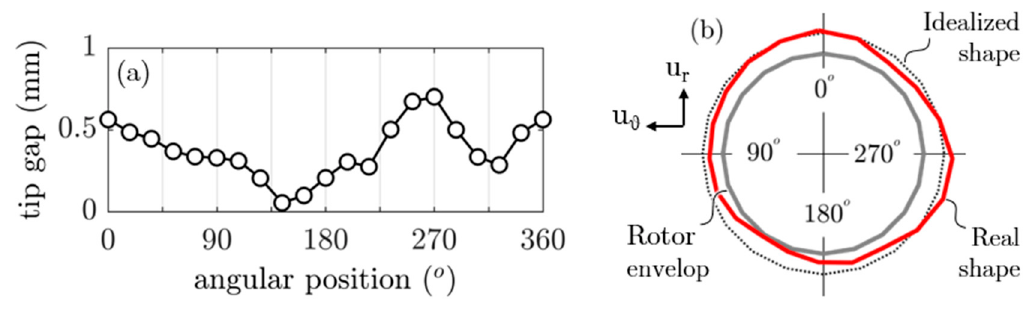
Figure 12. Evolution of the gap around the circumference of the compressor. ( a ) Tip gap size as a function of the angular position and ( b ) real shape of the casing.